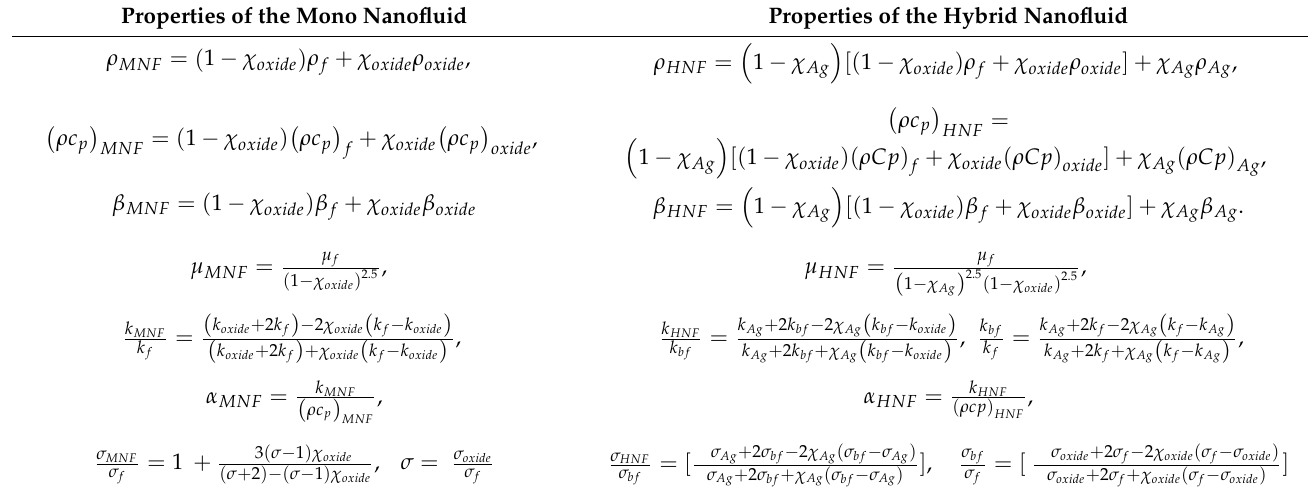
Table 1. Properties of mono and hybrid nanoliquids